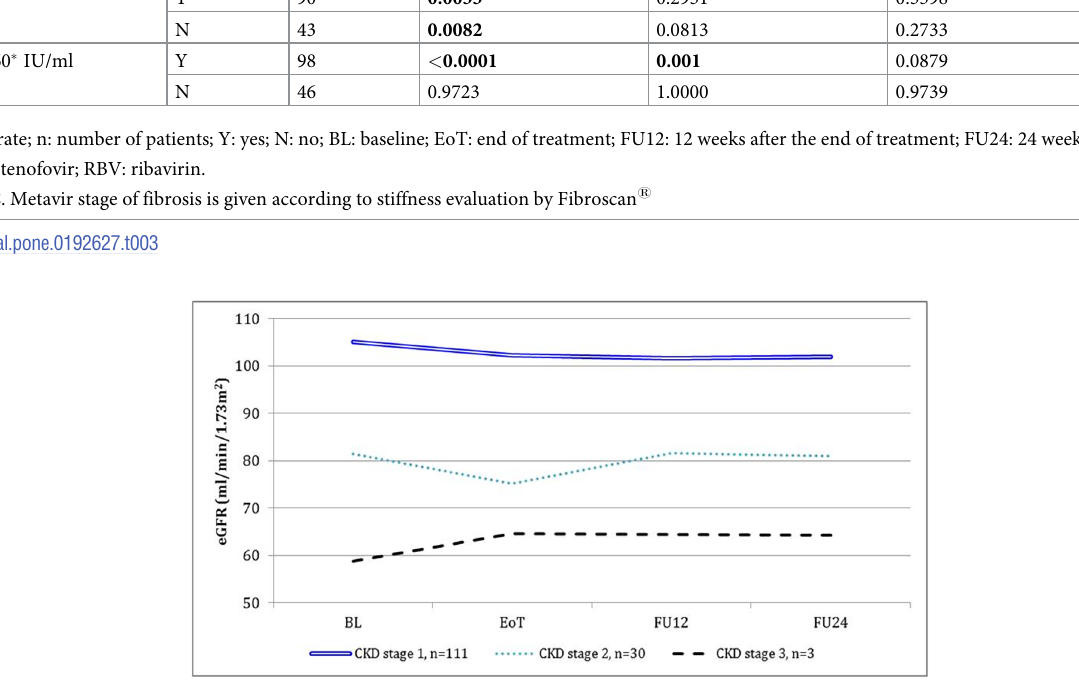
Fig 1. Trend of estimated glomerular filtration rate (eGFR) in the global population, according to GITMO renal stage at baseline (BL). n = number of patients in each chronic kidney disease (CKD) stage. EoT: End of treatment; FU12: follow-up 12 weeks after the EoT; FU24: follow-up 24 weeks after the